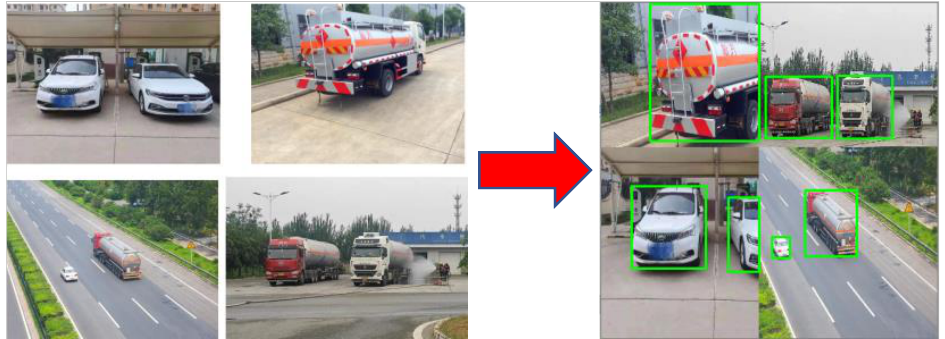
Figure 1. Illustration of the architecture of the Mosaic data